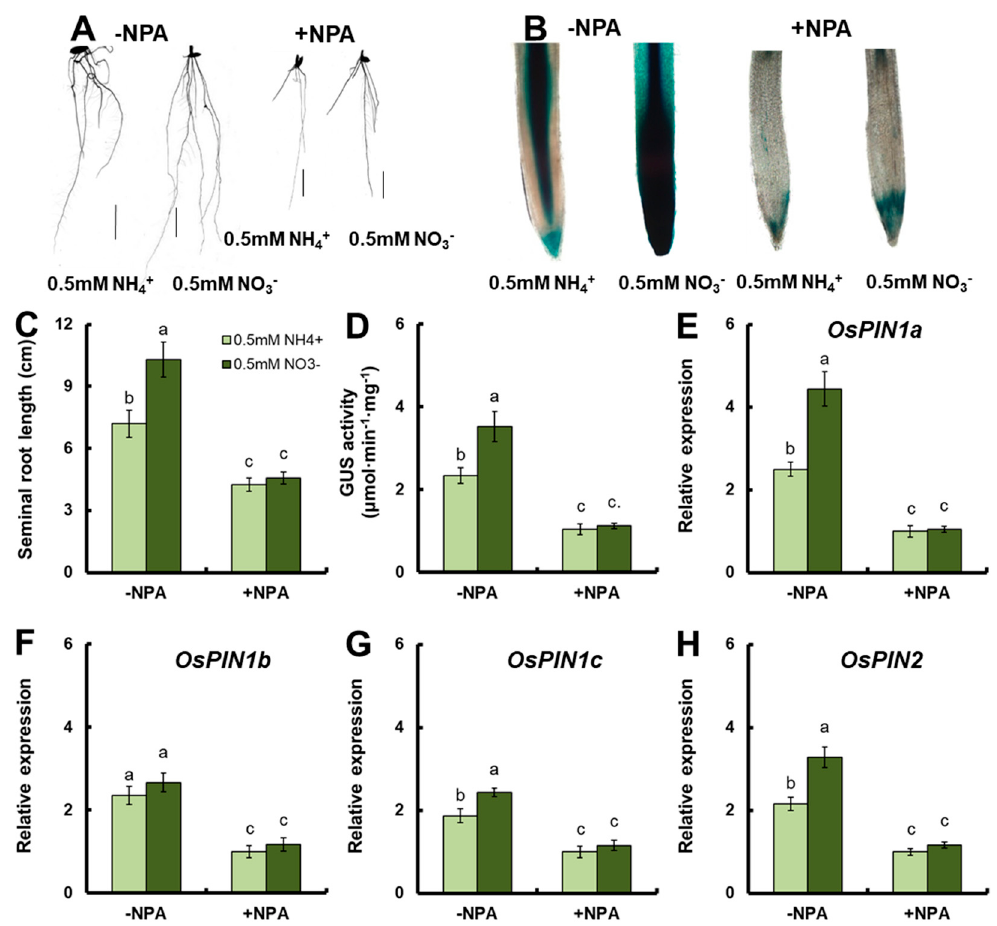
Figure 5. Effects of N-1-naphthylphalamic acid (NPA) on root growth under 0.5-mM NH 4+ or 0.5 mM NO 3 − conditions. Three-day-old normal grown pDR5::GUS transgenic seedlings were transferred to nutrient solutions containing 1 µM of NPA from 100 mM of NPA that was dissolved in DMSO (dimethyl sulfoxide), and the control containing the same amount of DMSO (dimethyl sulfoxide). Sampling was performed after seven days of treatment. ( A ) Root morphology of rice plants under 0.5-mM NH 4+ or 0.5-mM NO 3 − conditions with or without NPA treatment. (bar = 1 cm). ( B ) ß-Glucuronidase (GUS) expression in the root tips of pDR5::GUS seedlings under 0.5-mM NH 4+ or 0.5 mM NO 3 − conditions with or without NPA treatment. Root tips were stained for 2 h at 37 °C in the dark. ( C ) Seminal root length. ( D ) GUS activity of roots. Real-time quantitative RT-PCR analysis of the expressions of (E) OsPIN1a, ( F ) OsPIN1b, ( G ) OsPIN1c , and ( H ) OsPIN2 in pDR5::GUS seedlings under 0.5-mM NH 4+ or 0.5-mM NO 3 − conditions with or without NPA treatment. RNA was extracted from roots. Error bars: SE (n = 5). Significant differences between transgenic lines and WT are indicated by different letters ( p < 0.05, one-way ANOVA).